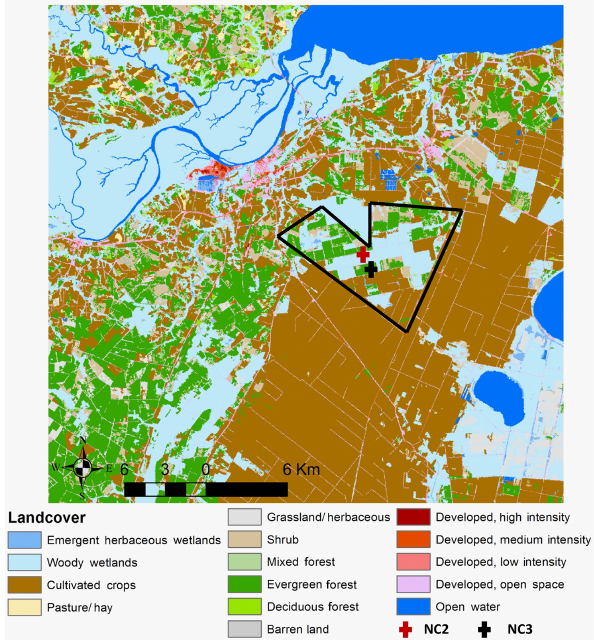
Figure 10. Land cover types over the study area from NLCD 2006. Area in the black outline is the plantation